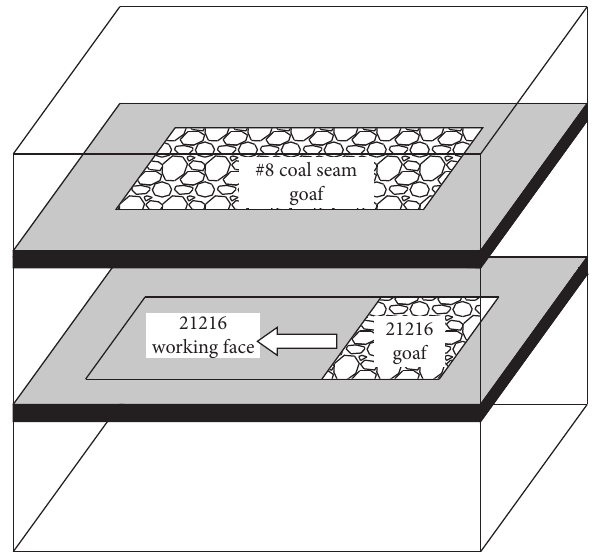
Figure 1: Schematic diagram for the spatial location relationship of the coal seam.